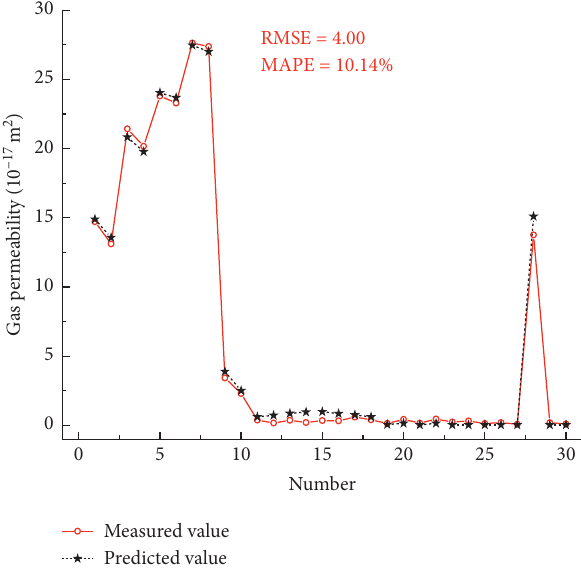
Figure 10: Predictive permeability and measured